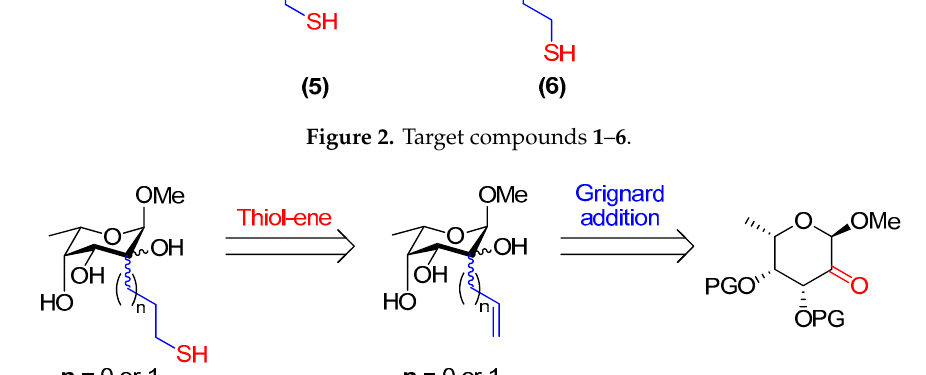
Figure 2. Target compounds 1 – 6 .